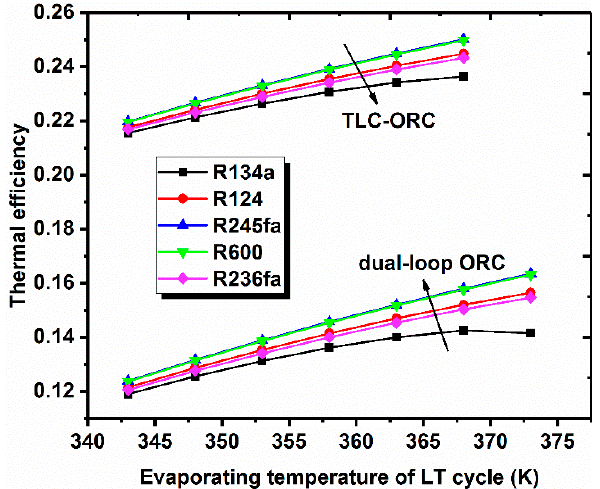
Figure 13. Comparison of thermal efficiency between the two systems under different LT working fluids and T LT,evap .